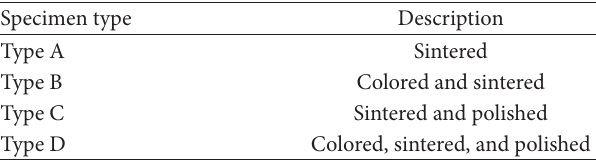
Table 1: Nomenclature of zirconia core